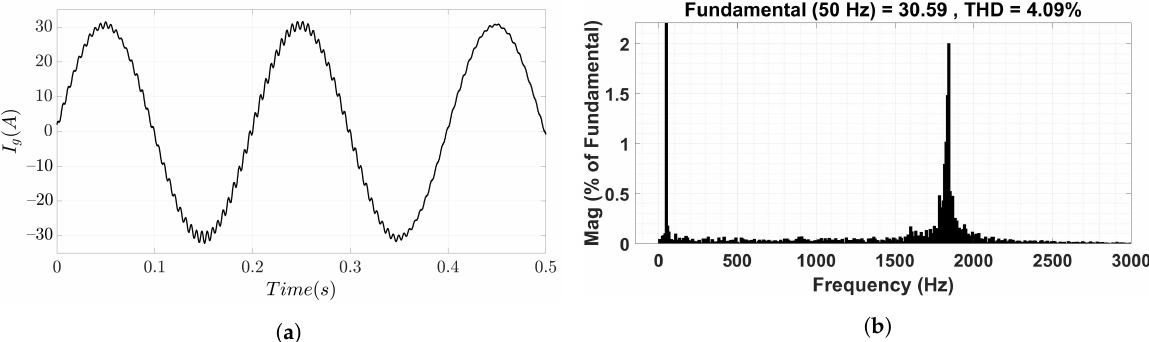
Figure 14. Simulation results of two identical parallel VSIs connected to the grid. ( a ) Grid current waveform. ( b ) Harmonic spectrum of grid current.